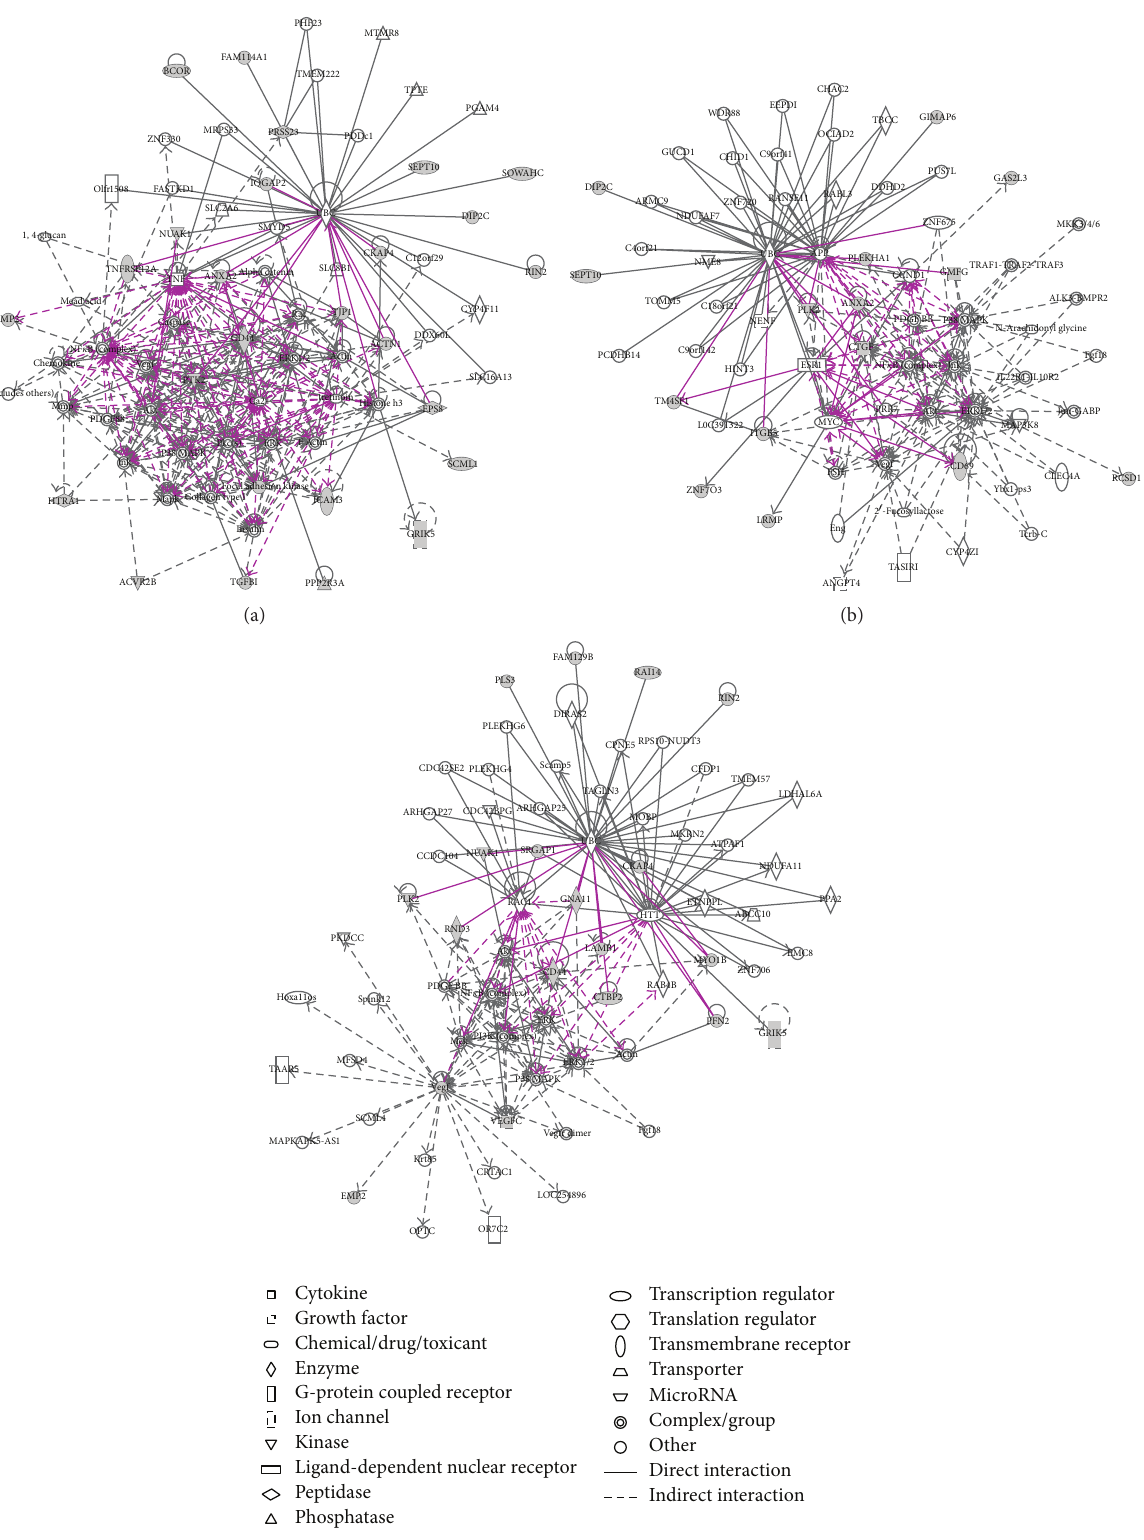
Figure 6: Gene regulatory networks of the survival-related genes generated by IPA. (a) 26-gene set for glioma; (b) 16-gene set for colon cancer; and (c) 18-gene set for ovarian cancer. Shapes represent different molecule types (details are illustrated in bottom middle panel). Filled shapes represent the survival-related candidate genes. Solid line indicates direct interaction and dashed line indicates indirect